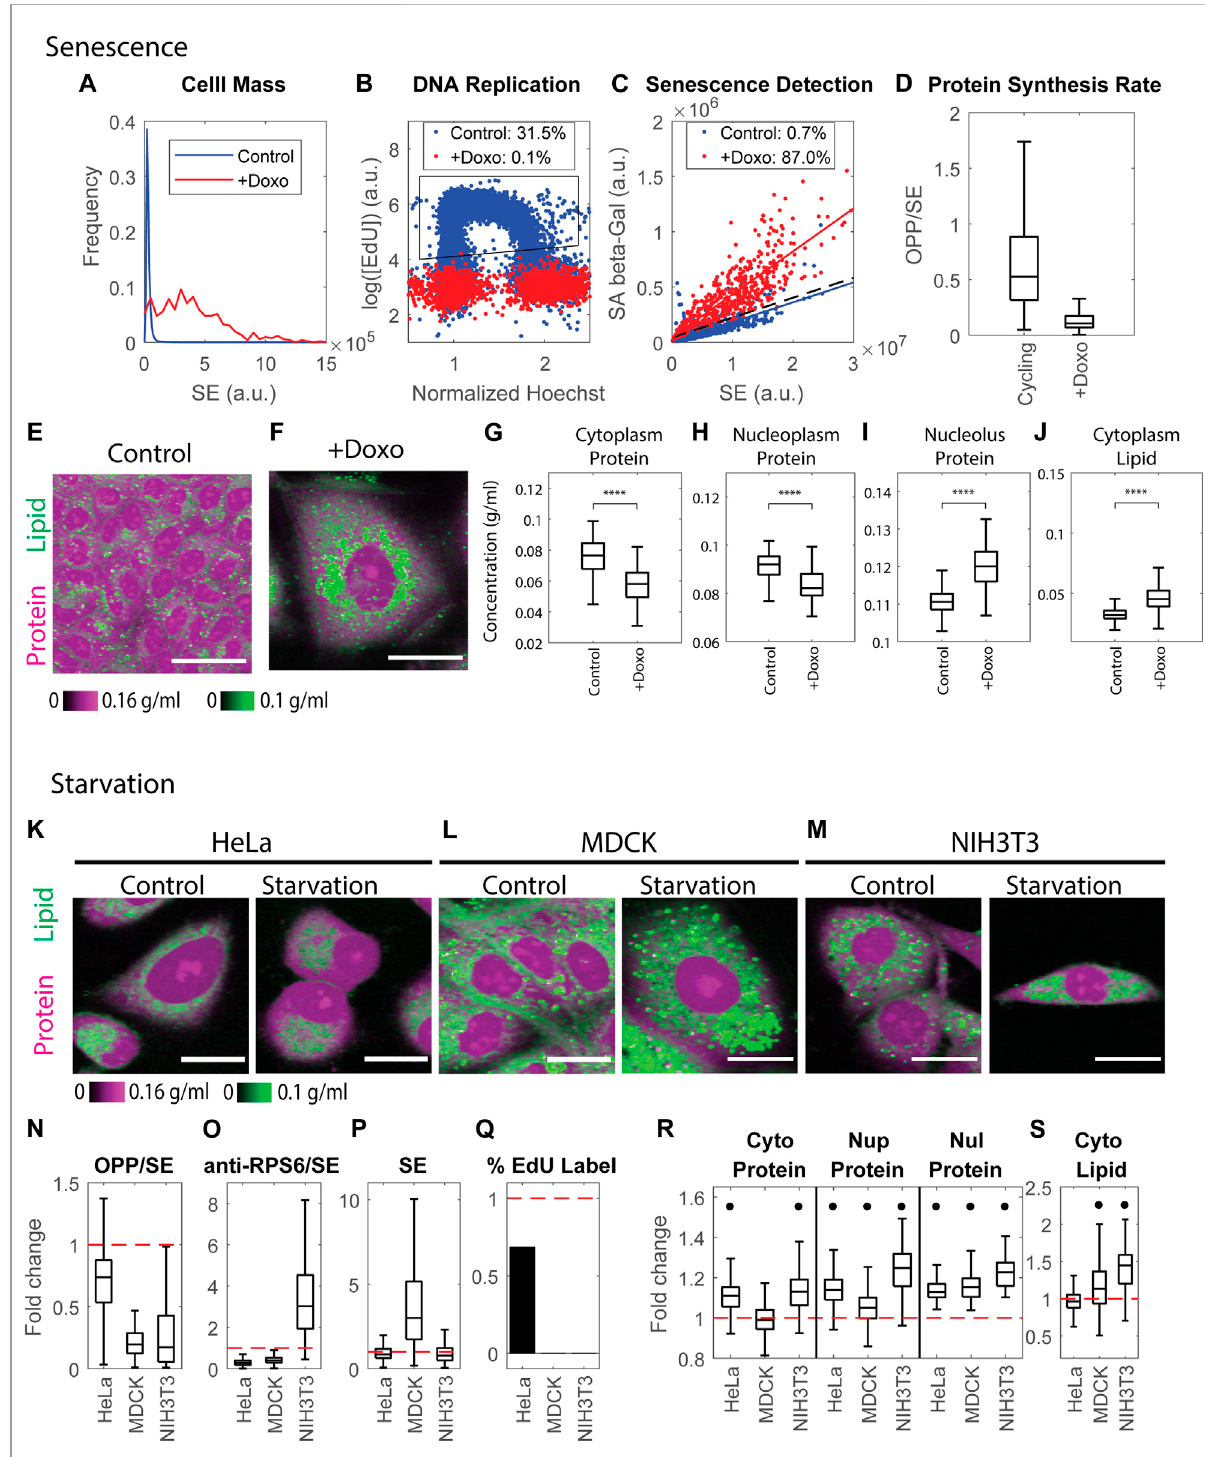
FIGURE 7 Cell senescence and quiescence change mass densities dramatically. (A) Cell mass distributions quanti fi ed by the SE protein stain in untreated MDCK cells and MDCK cells treated with 100 ng/ml Doxorubicin for 5 days. n = 26391(Control), n = 523 (+Doxo). (B) DNA replication detected by EdU incorporation in untreated MDCK cells and MDCK cells treated with 100 ng/ml Doxorubicin for 5 days. n = 17816 (Control), n = 1939 (+Doxo). Legends indicate the percentage of cells in the gated region (black polygon) of EdU incorporation. (C) Senescent cells detected by SA- β - galactosidaseactivityvs.SEproteinstain.Eachdotisanindividualcell.Solidcoloredlinesarethelinear fi tofthecorrelation.Thedashedblackliney=